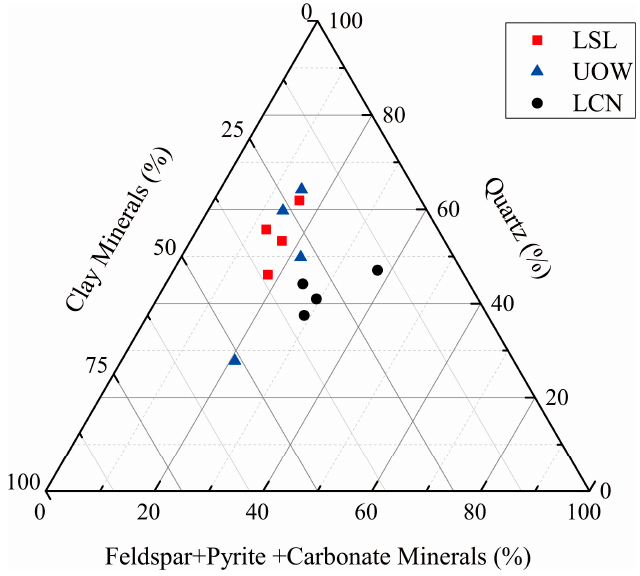
Figure 4. The mineral compositions of the collected shale samples.